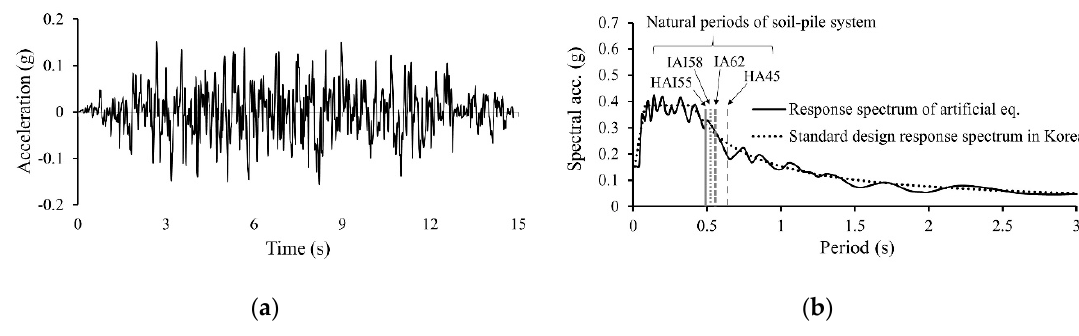
Figure 5. Input ground acceleration: ( a ) input seismic wave and ( b ) comparison of the response spectra and natural periods of soil-pile system